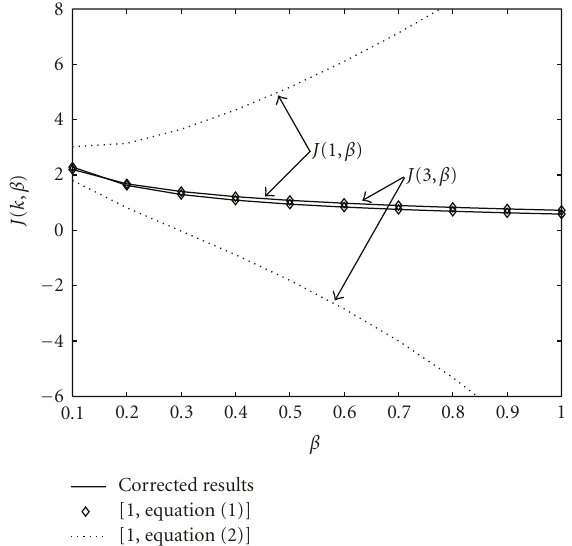
Figure 1: Comparisons between the correct and the wrong expres-